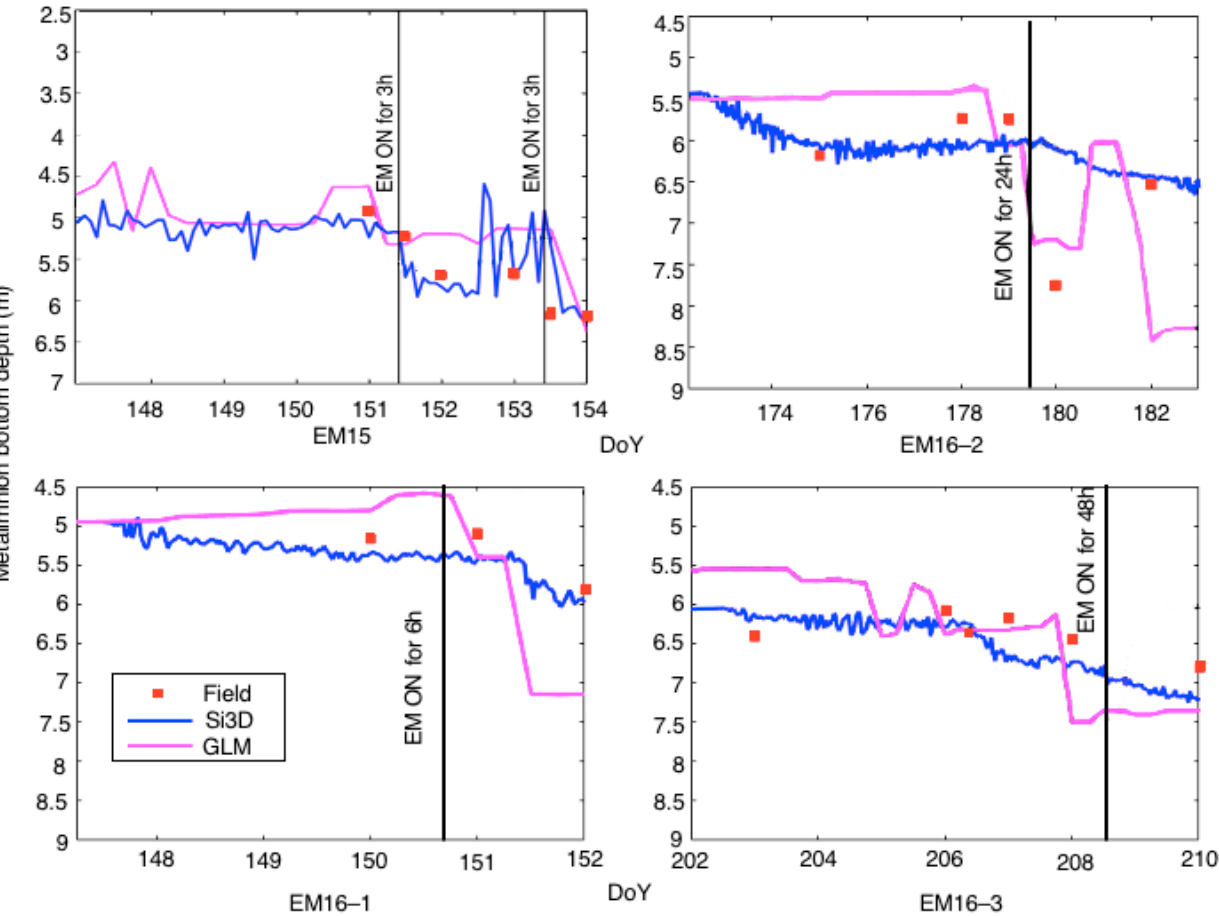
Figure 7. The field and simulated metalimnion bottom depths during the EM periods of 2015 and 2016. Table 7. RMSEs (in m) of simulated metalimnion bottom depths during the EM periods of 2015 and 2016.